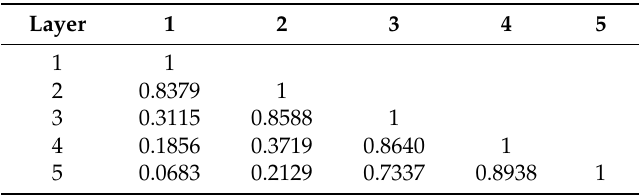
Table 1. Correlation of elevation cuts in neighbor elevation angles in a volume.